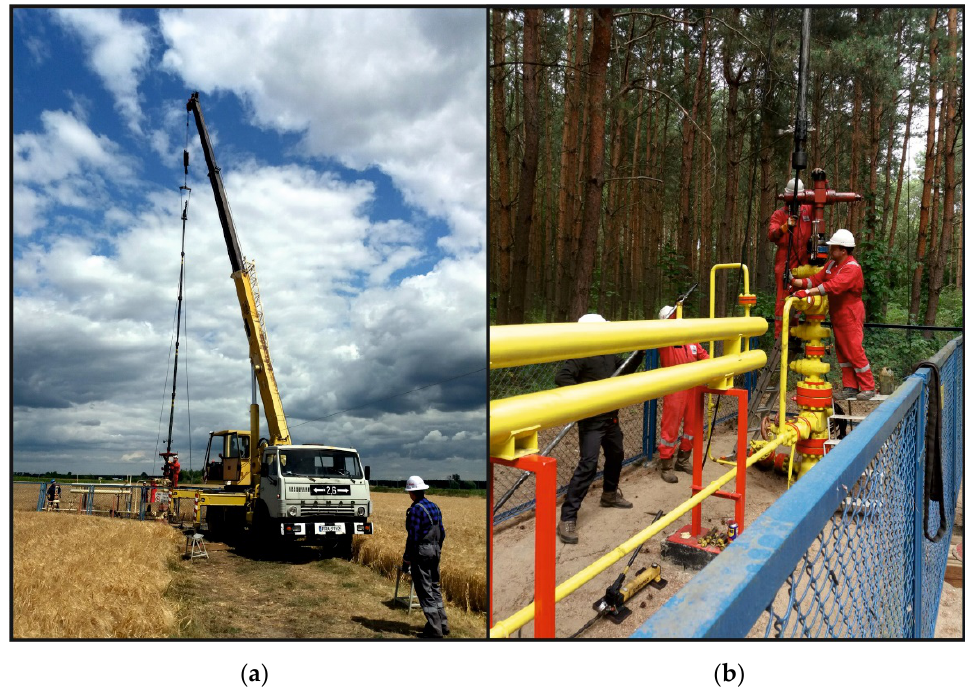
Figure 1. Sampling of bottomhole samples; ( a ) assembling lubricator at B-24 well; ( b ) pulling out the bottomhole samplers from the B-22 well lubricator.